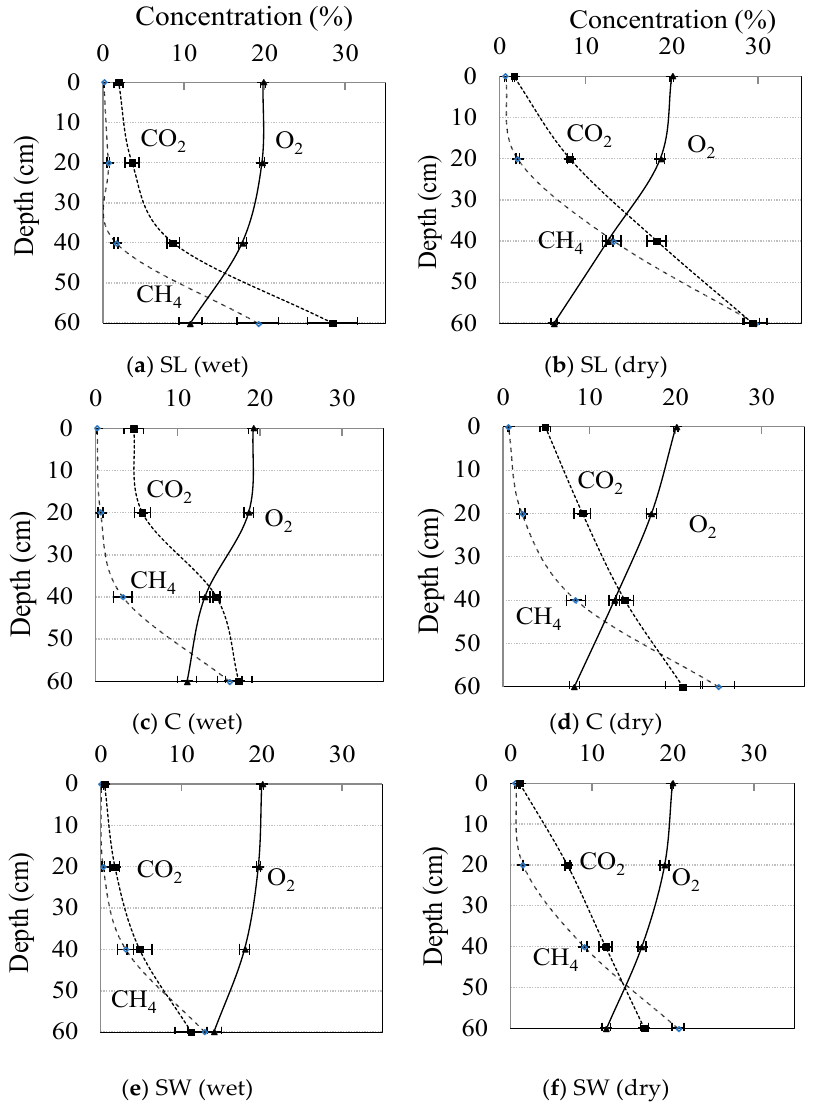
Figure 2. Gas concentration profiles observed in sandy loam (SL), compost (C), and stabilized waste (SW) media during wet and dry periods.